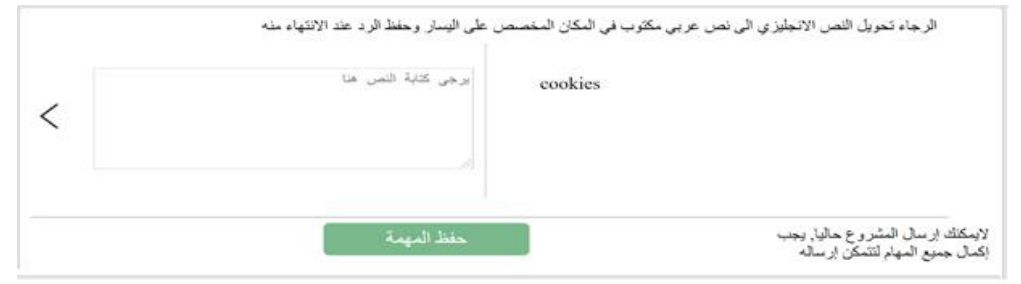
Figure 9. Micro-task request page.